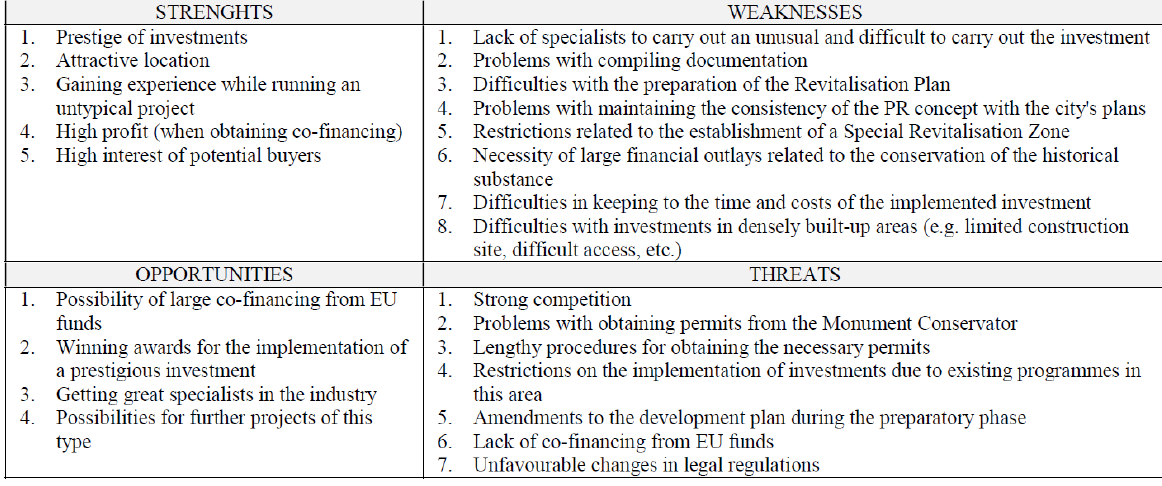
Figure 4: Example of a SWOT matrix for a potential investor planning a construction project in the area covered by the Revitalisation Pro- gramme (own